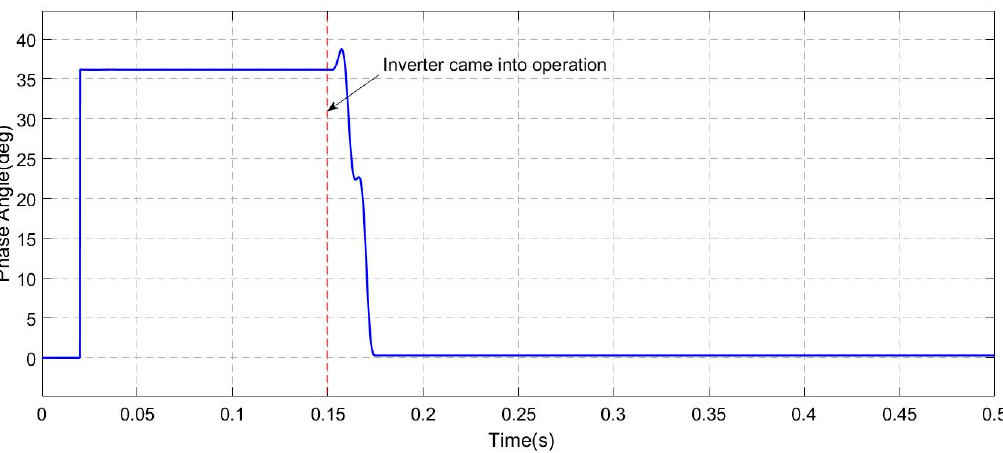
Figure 13. Waveform of phase difference between voltage and current.